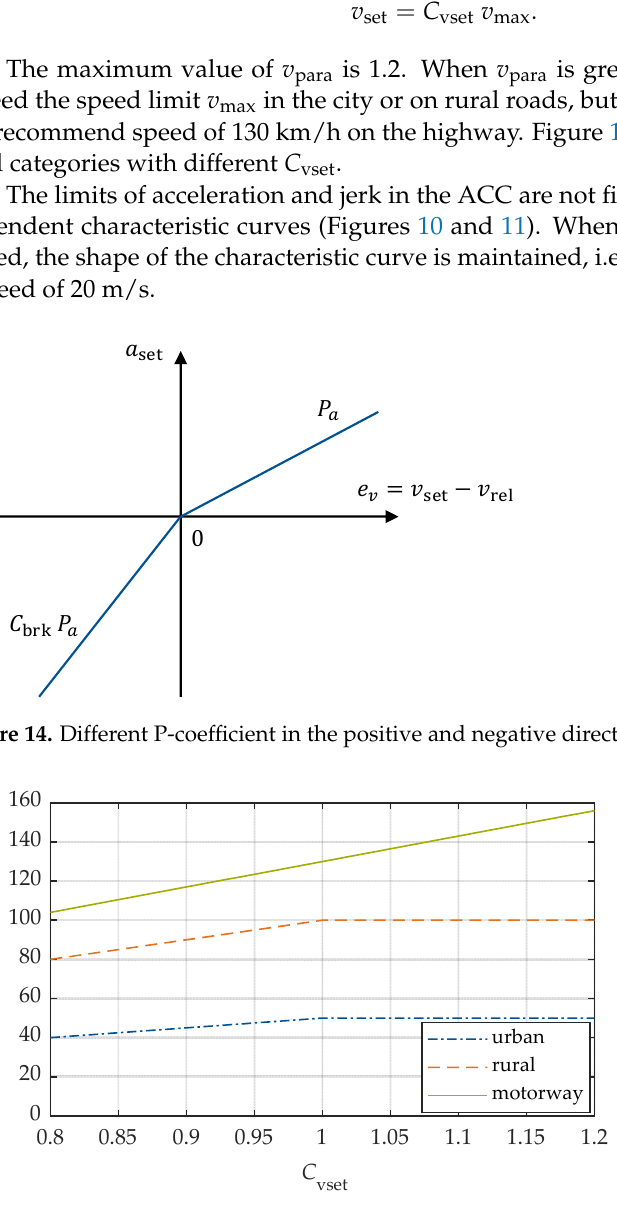
Figure 15. Target speed for different road categories.